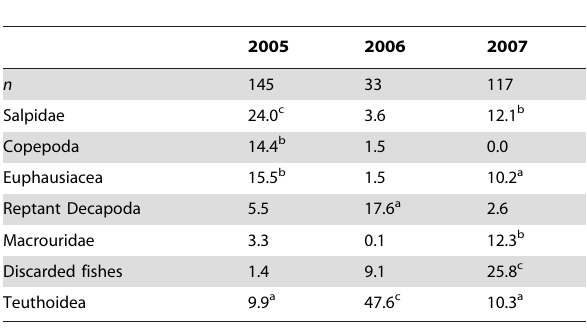
Table 2. Squalus acanthias diet by year.